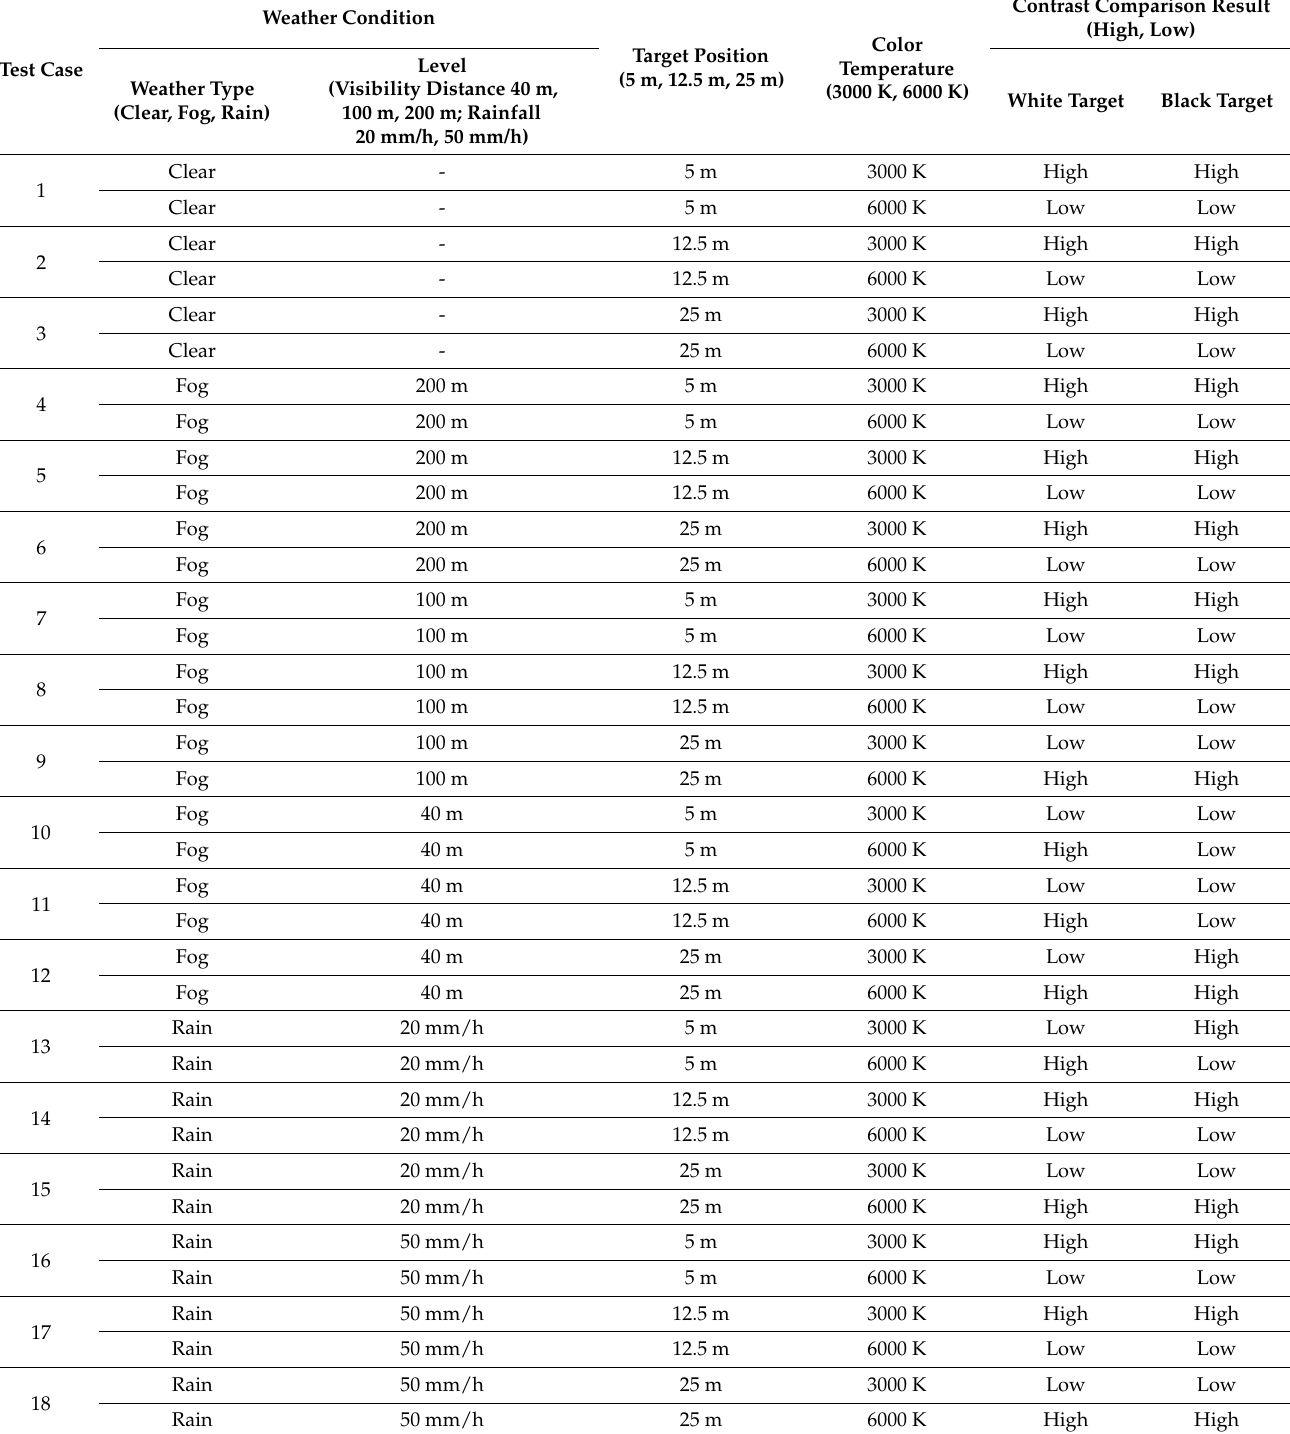
Table 15. The results of comparing the contrast for each test